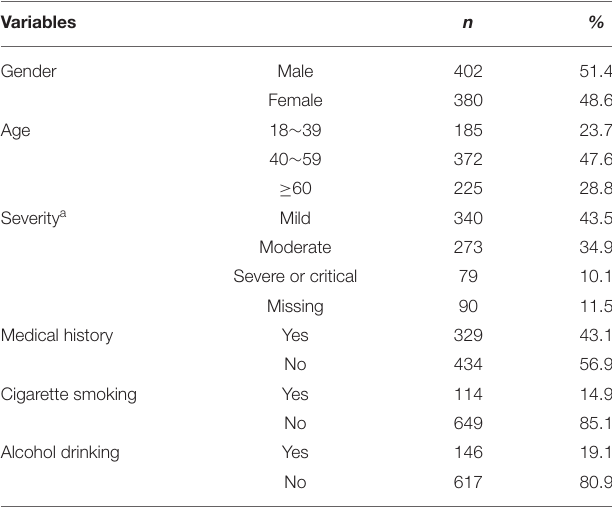
TABLE 1 | Demographic, medical and behavioral information of the discharged COVID-19 patients.